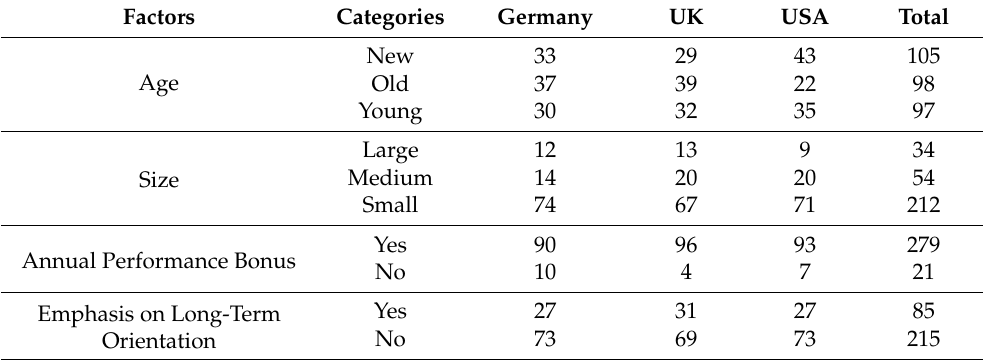
Table 1. Summary of responses.